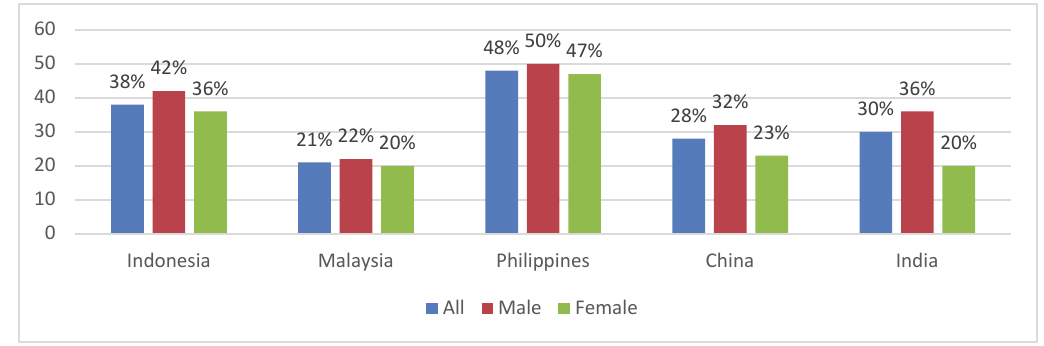
Fig. 2. Entrepreneurship Prevalence Rates by Gender in different Asian Countries Source (World Bank,